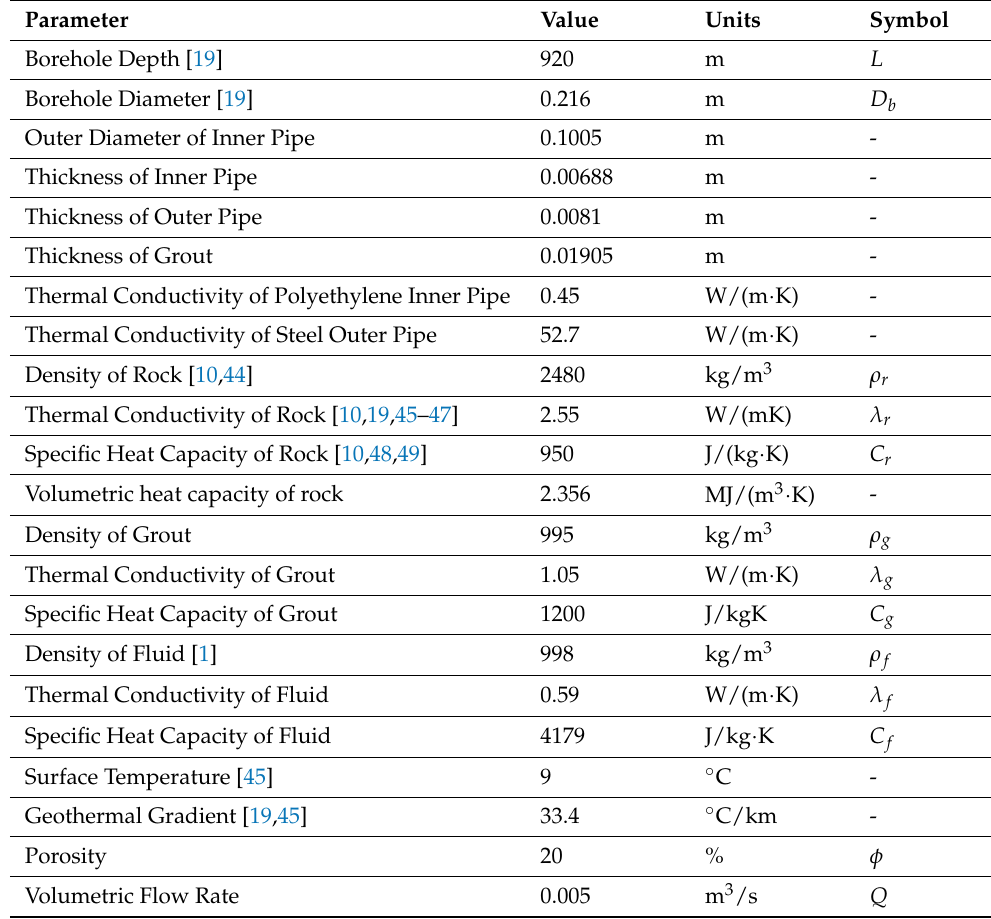
Table 1. Thermo-physical parameters of the model. Model parameters are either taken from the literature, assumed unpublished values (compiled by [42,43]), calculated values or given as the most likely value. Note the inner pipe is the coaxial pipe and the outer pipe is the casing. The real nature of the casing situation is notably more complex than that modelled. The thermal properties of the rock in the subsurface are taken as the weighted average from Kolo et al. [10].